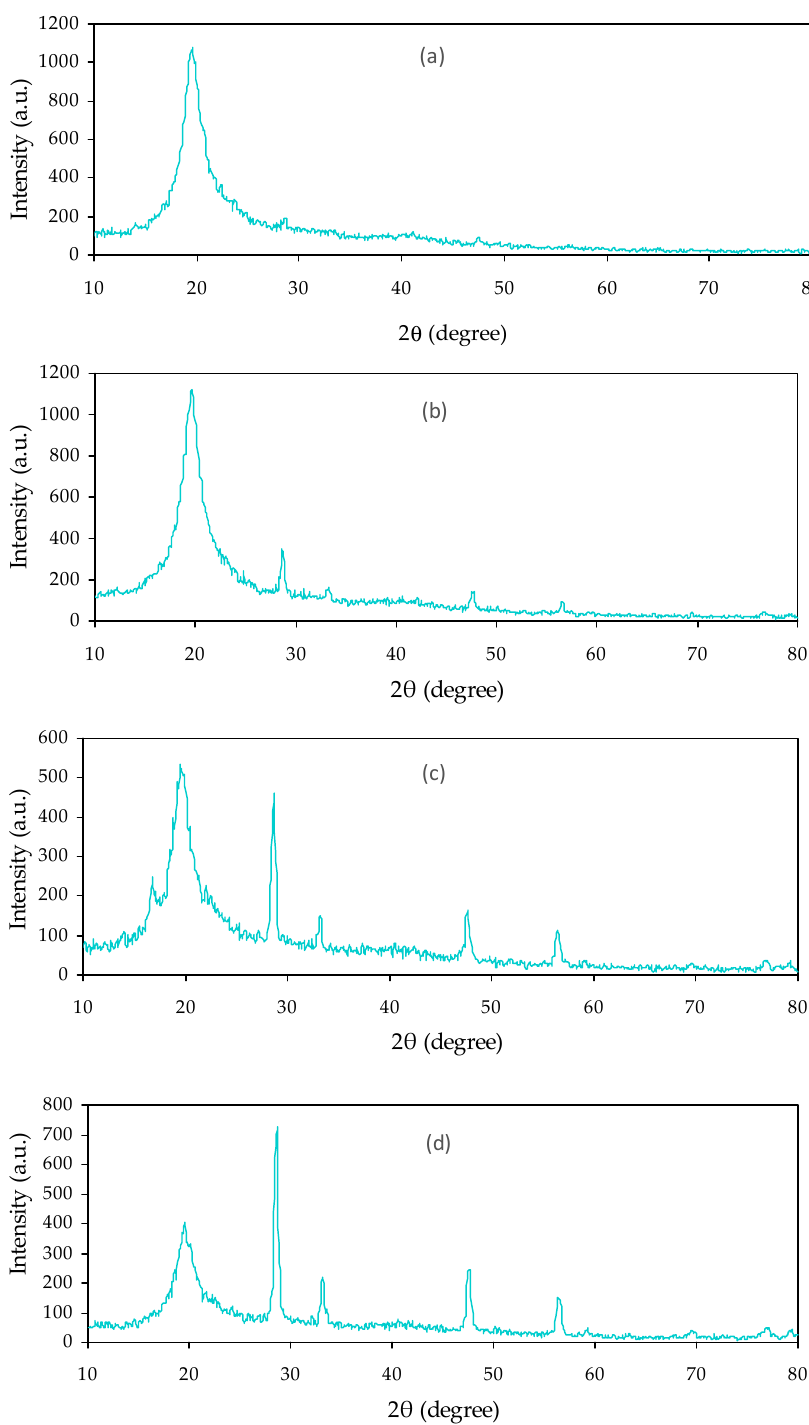
Figure 1. XRD pattern of neat PVA film.